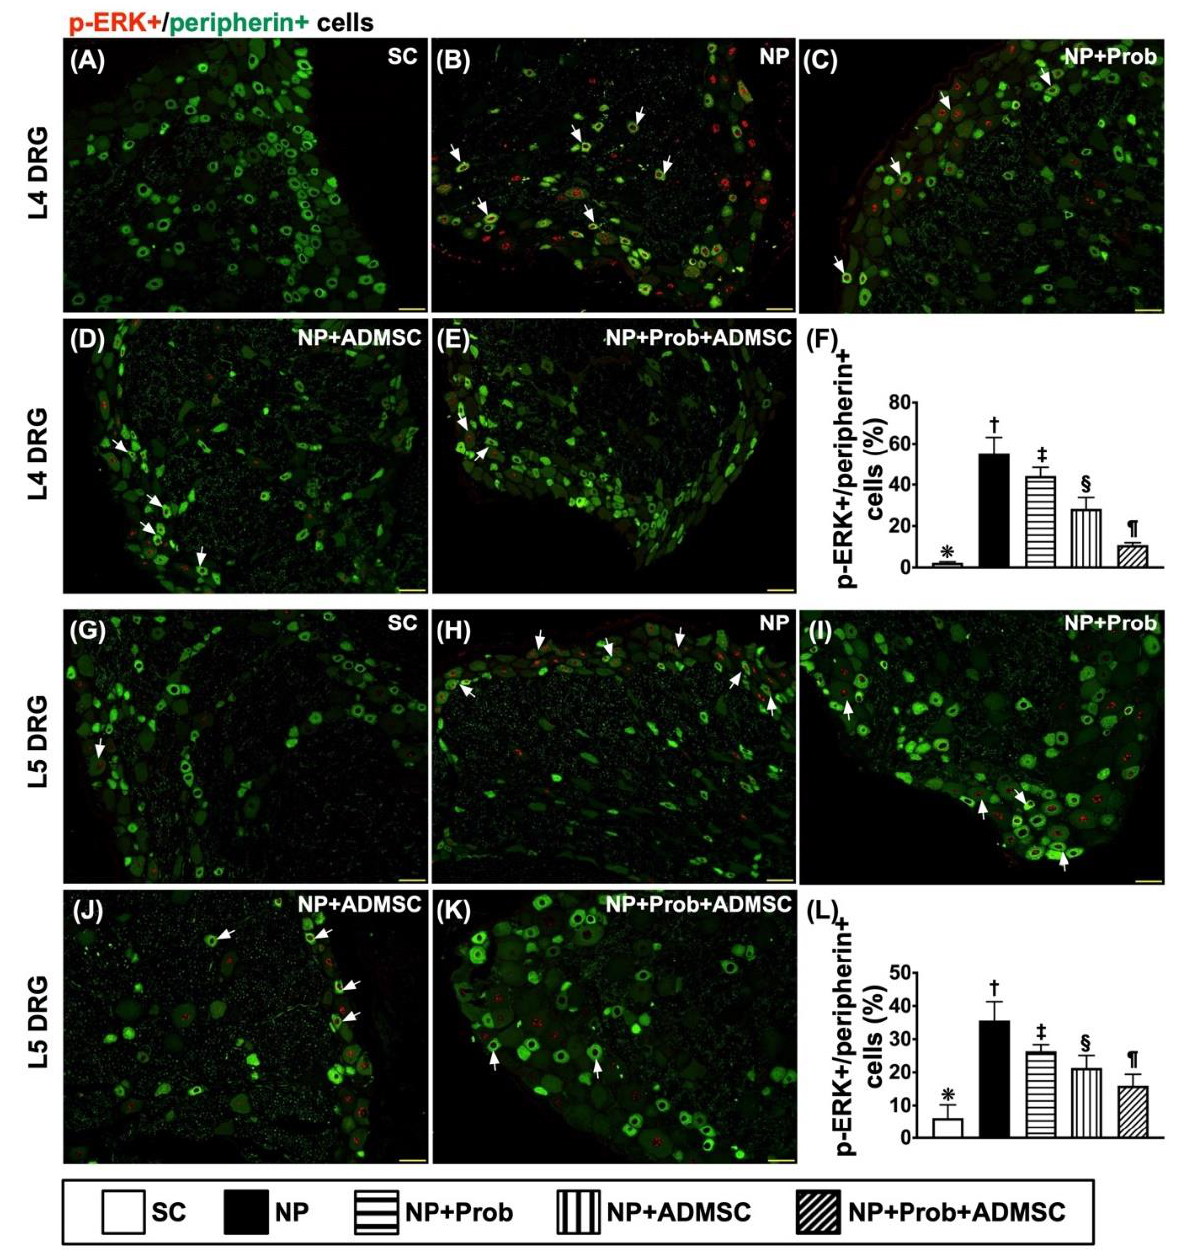
Figure 7. Cellular expression of co-localizations between p-EKR and peripherin in L4-L5 DRGs by day 60 after NP induction. L4-DRG level: ( A – E ) Showing the immunofluorescent (IF) microscopic findings (200 × ) to identify merged positively stained p-ERK and peripherin (green–red colocaliza- tion). ( F ) Analytical results of number of p-ERK+/peripherin+ cells, * vs. other groups with different symbols (†, ‡, §, ¶), p < 0.0001. L5-DRG level: ( G – K ) Showing IF microscopic findings (200 × ) to identify merged positively stained p-ERK and peripherin (green–red colocalization). ( L ) Analytical results of number of p-ERK+/peripherin+ cells, * vs. other groups with different symbols (†, ‡, §, ¶), p < 0.0001. Note that the white arrows indicate the merged double stain of p-ERK+/peripherin+. Scale bars in the lower-right corner represent 50 µ m. Symbols (*, †, ‡, §, ¶) indicate significance for each other (at the 0.05 level). All statistical analyses were performed using one-way ANOVA followed by Bonferroni multiple comparison post hoc test (n = 8 for each group). SC = sham control; NP = neuropathic pain; Prob = probiotics; ADMSCs = adipose-tissue-derived mesenchymal stem cells.